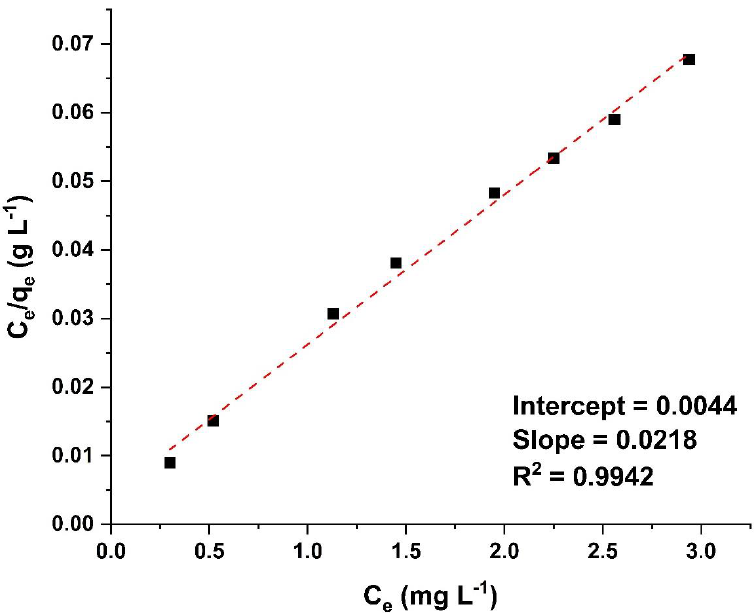
Figure 9. Langmuir adsorption isotherm of COD by activated